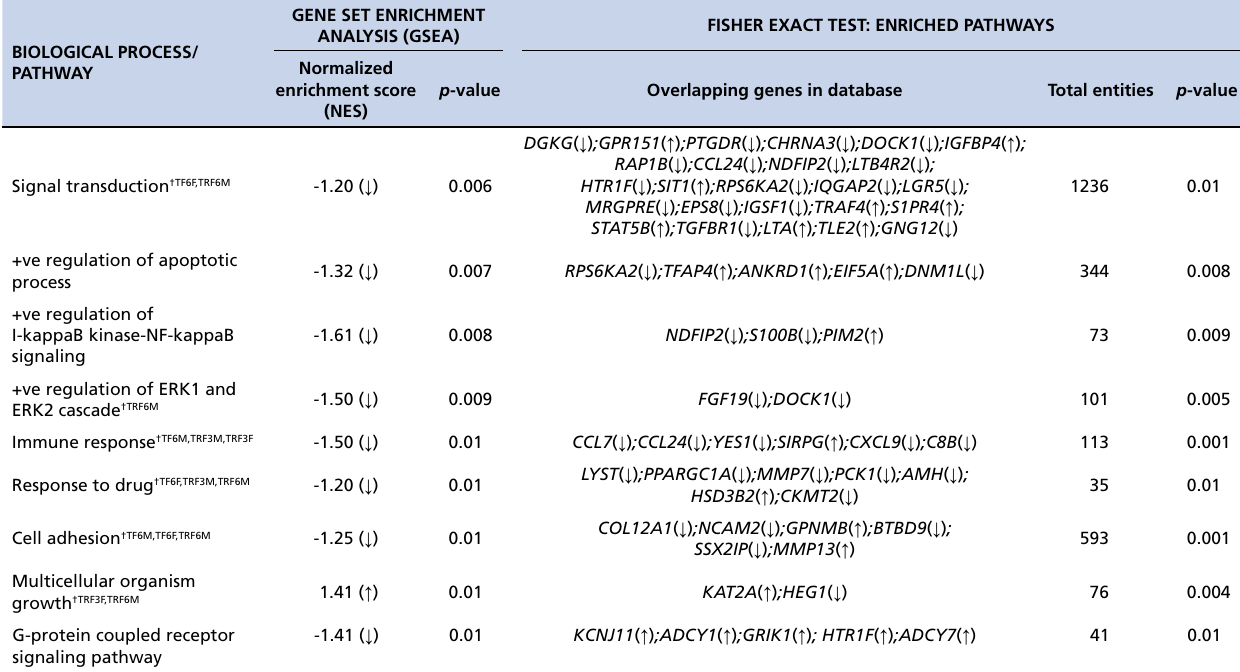
Supplementary Table 8 - List of biological processes significantly modulated in female subjects after 6 months of TRF